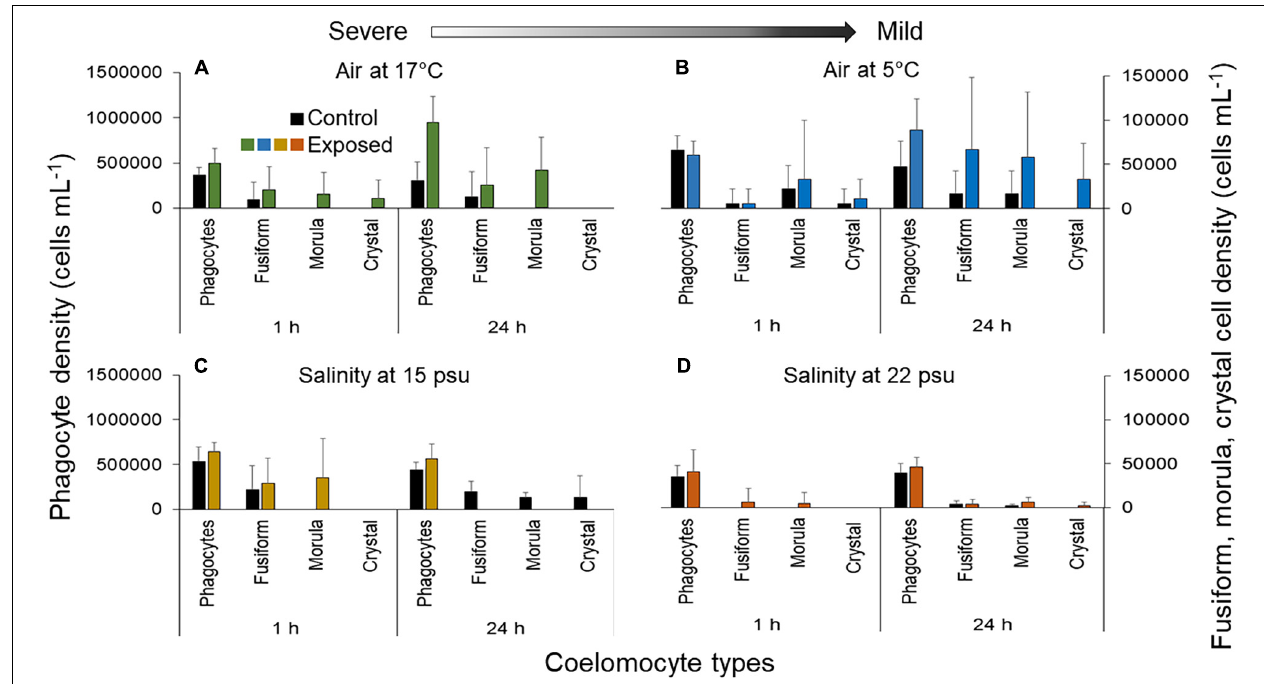
FIGURE 2 | Number of free coelomocytes (separated by cell type) per mL of fluid in the Polian vesicle fluid of sea cucumbers (mean ± SD, n = 5–10) following exposure to (A) 17 ◦ C air, (B) 5 ◦ C air, (C) 15 psu salinity, and (D) 22 psu salinity. Values on the left axis correspond to the density of phagocytes and values on the right axis correspond to the density of fusiform, morula and crystal cells (note the order of magnitude difference in scales). Measurements were made immediately after the exposure (1 h) and after a 23 h recovery period (total duration of 24 h). Arrow indicates severe and mild stressors relative to the